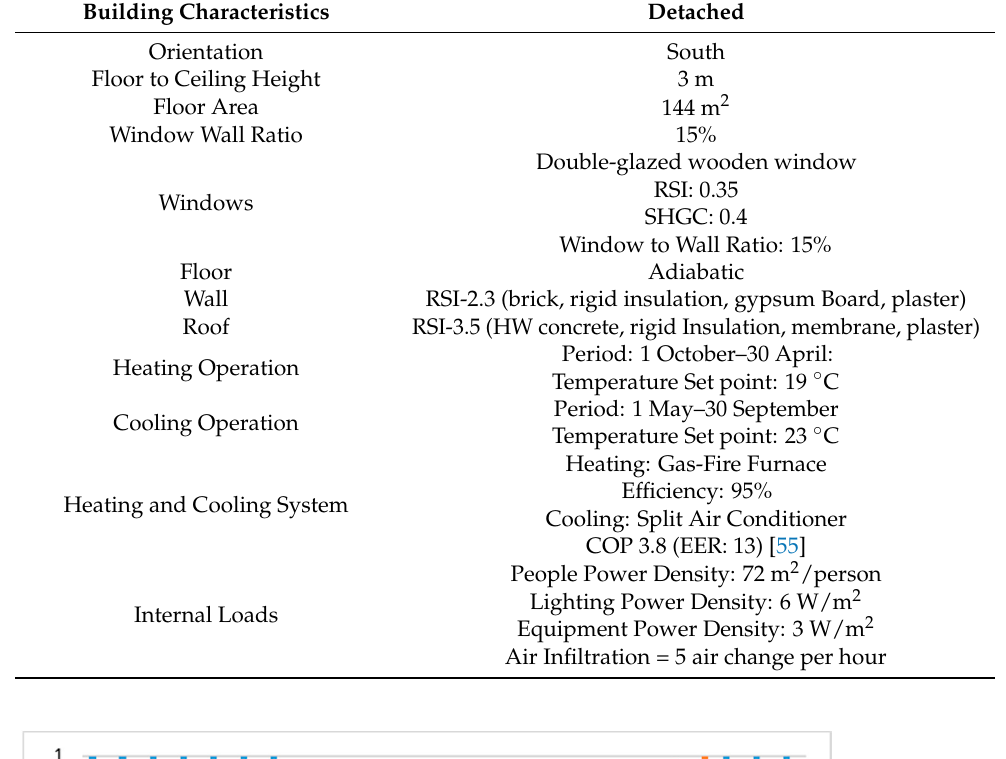
Table 1. Main characteristics of baseline residential building energy model.